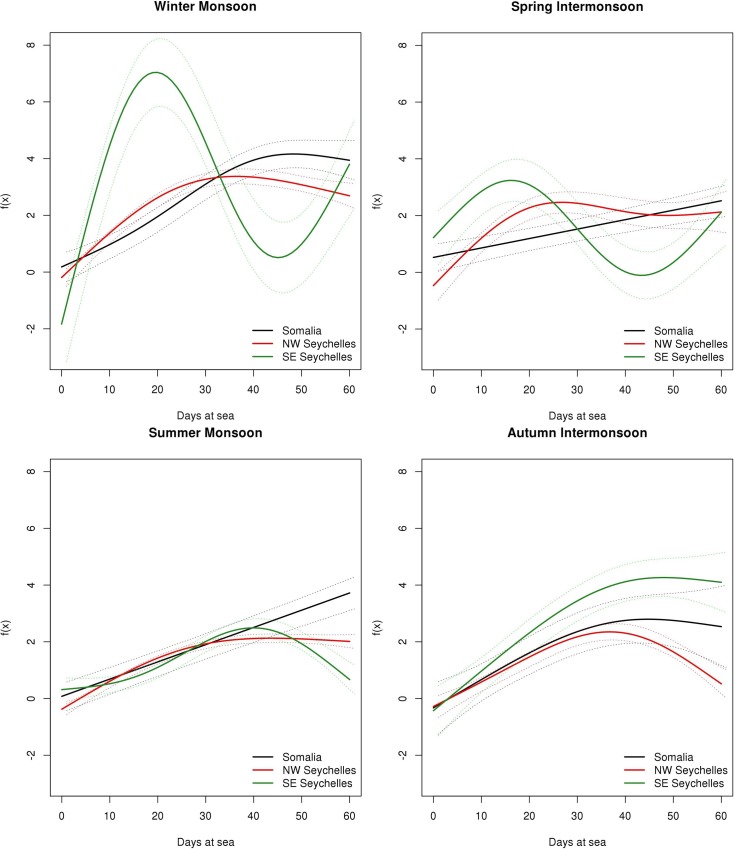
Functional shapes of the non-parametric relationship between tuna biomass and days at sea with 95% confidence intervals (dashed lines), for each period considered.